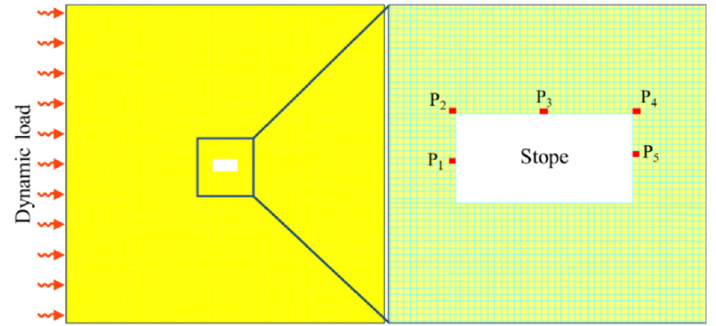
Figure 8. Explicit solution model II (top dynamic loading).